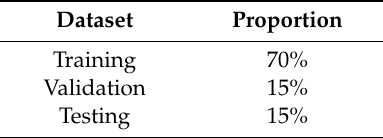
Table 2. Distribution of the